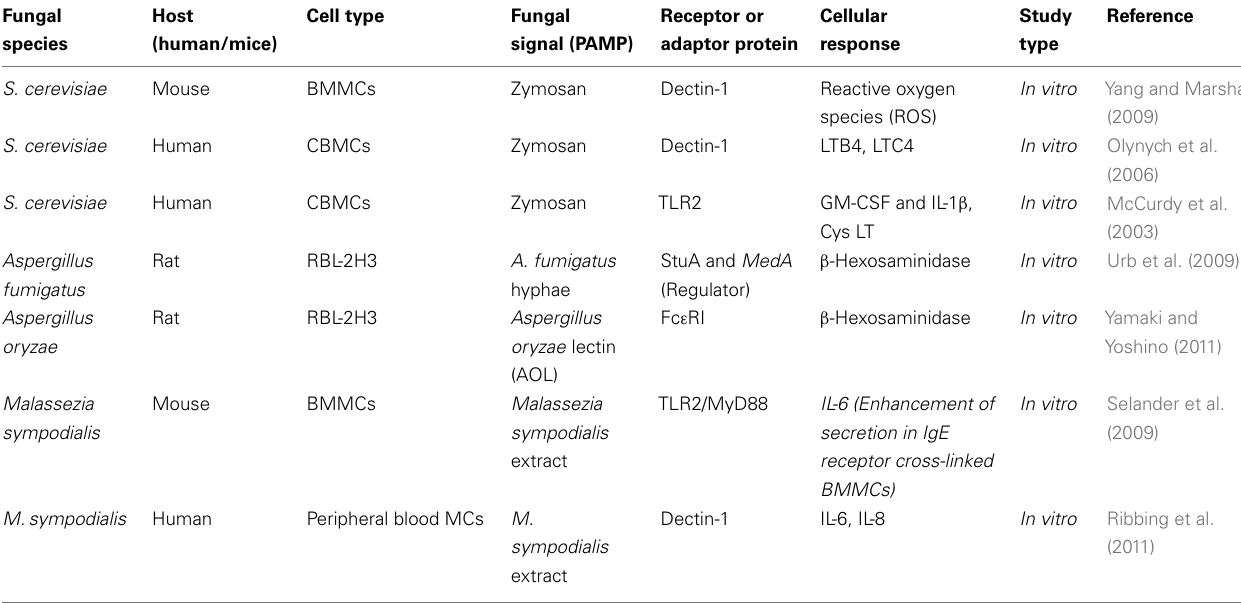
Table 1 | Possible mechanism of fungal recognition by mast